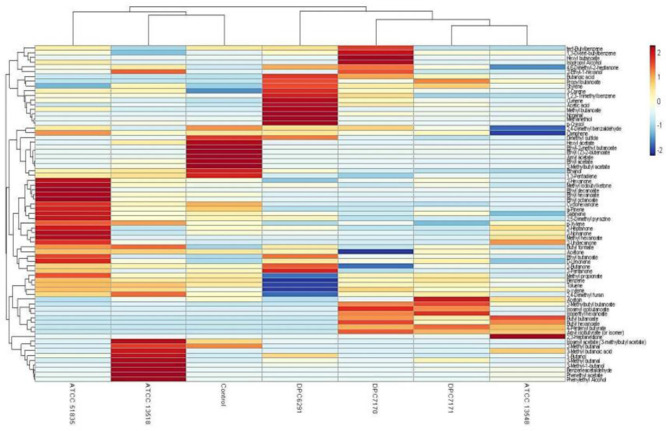
Hierarchical clustered heat map illustrates Trial 1 result of relative abundance of variable compounds separating high CEP and esterase active (ATCC13548, DPC7171, DPC7170, and DPC6291) strains from those with comparatively low CEP and esterase activity (ATCC 135185 and ATCC 51835) M. caseolyticus subsp. caseolyticus after 24 h incubation in LFM detected via HS-SPME GC-MS.